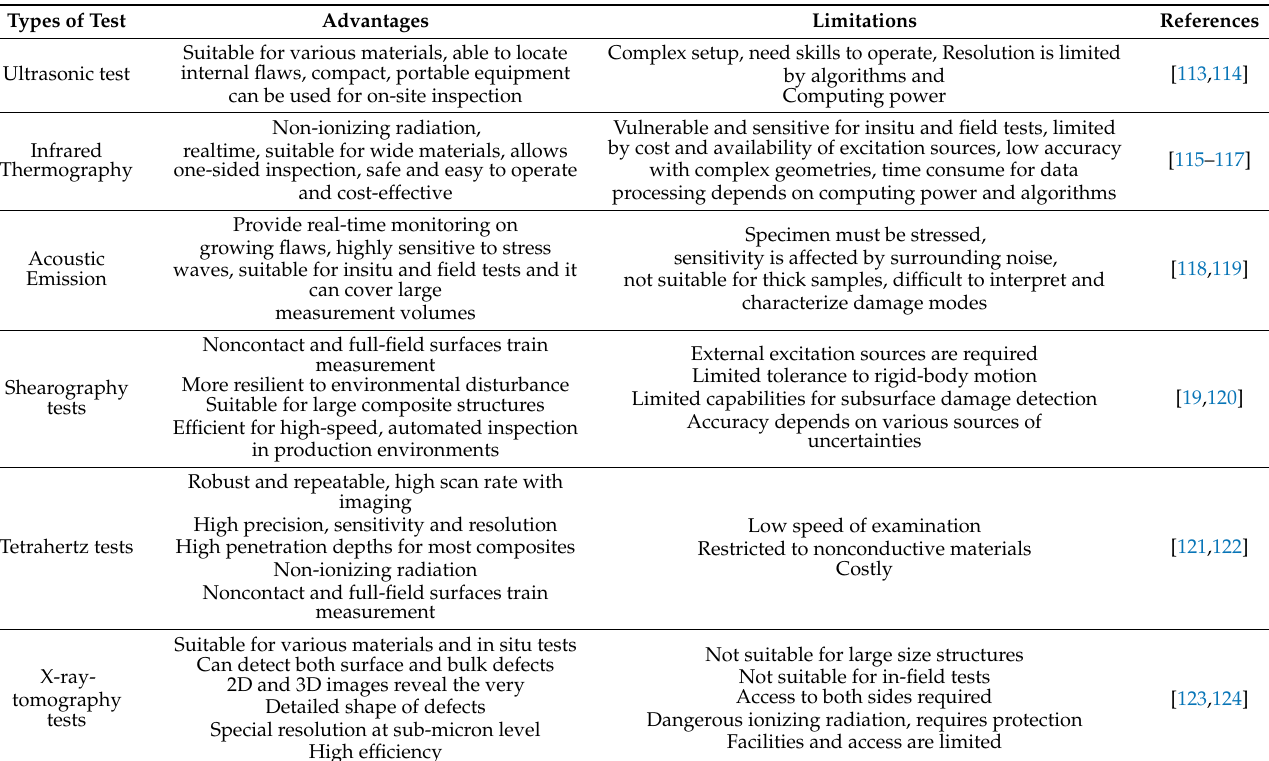
Applications, advantages and limitations of the advanced Nondestructive testing methods used for damage